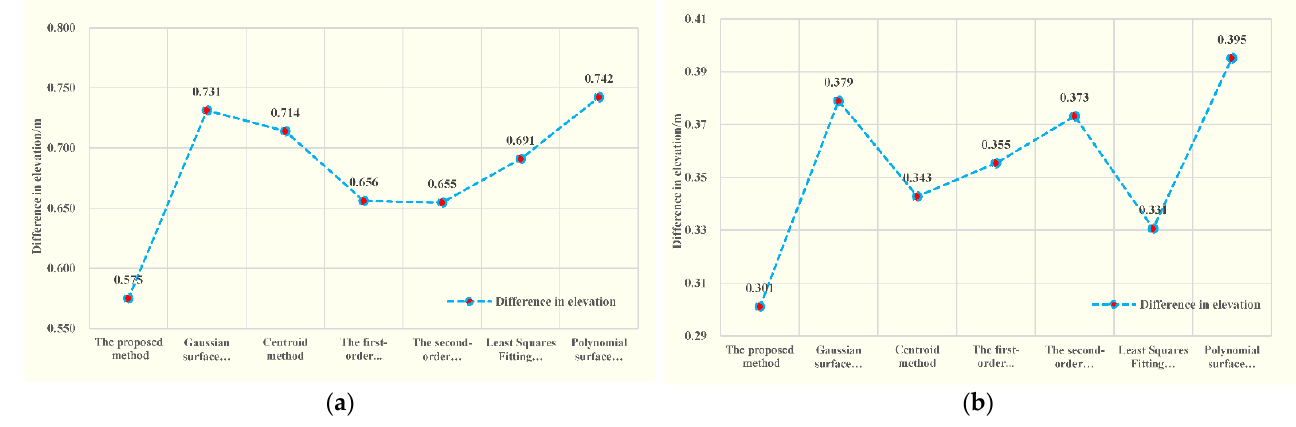
Figure 17. Elevation accuracy of laser footprints positioned with calibration parameters obtained with different methods for beam 1 ( a ) and beam 2 ( b ) on slopes.